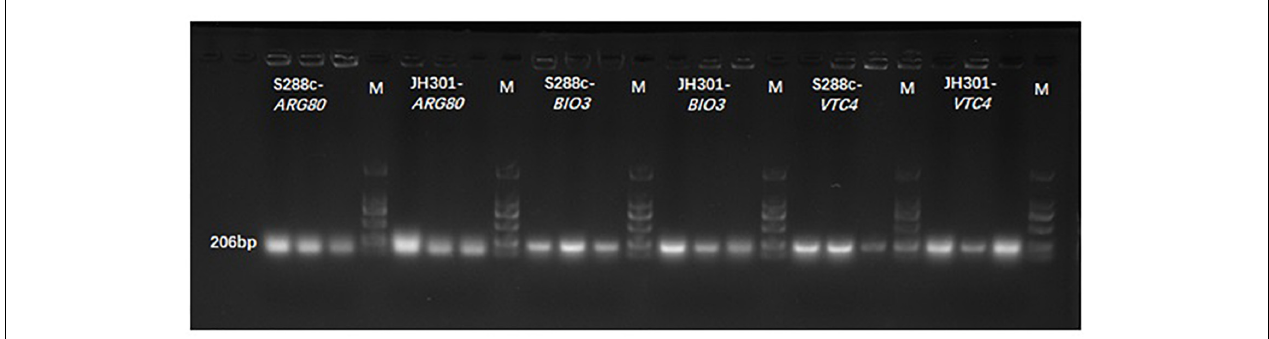
FIGURE 5 | Banding patterns of the PCR products. M means marker; S288c- ARG80 means the PCR bands of ARG80 gene of strain S288c; JH301- ARG80 means the PCR bands of ARG80 gene of strain JH301; S288c- BIO3 means the PCR bands of BIO3 gene of strain S288c; JH301- BIO3 means the PCR bands of BIO3 gene of strain JH301; S288c- VTC4 means the PCR bands of VTC4 gene of strain S288c; JH301- VTC4 means the PCR bands of VTC4 gene of strain JH301.